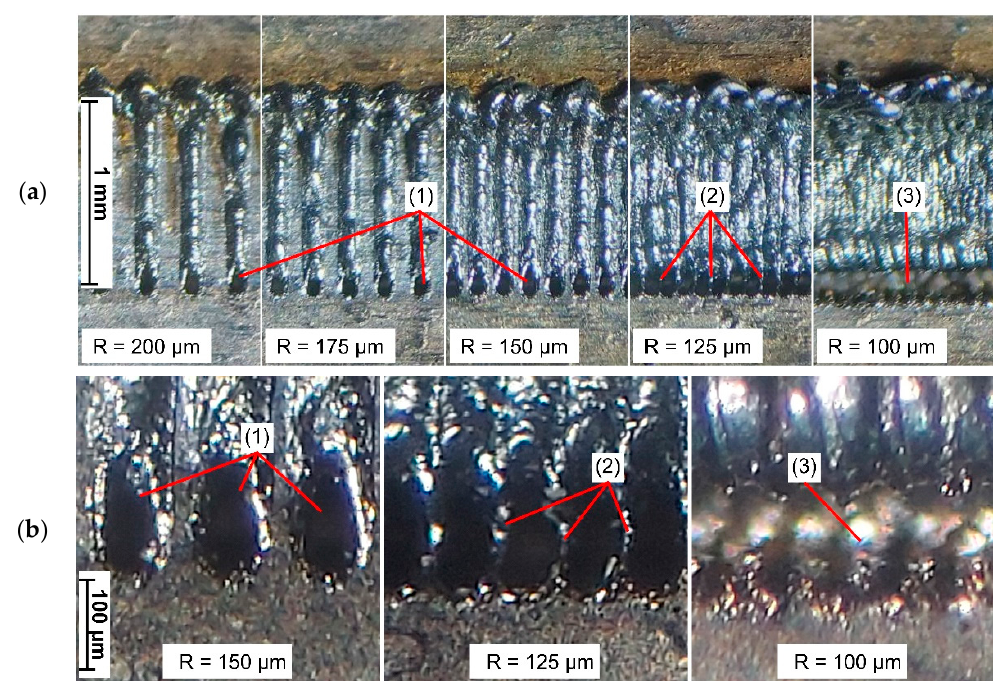
Figure 4. Graphs of the dependences of the investigated parameters ( a ) D, P and ( b ) S, H on the distance between the vectors ( R ), as well as ( c ) the transverse sections of the grooves obtained at different values of R (10–100 µm).